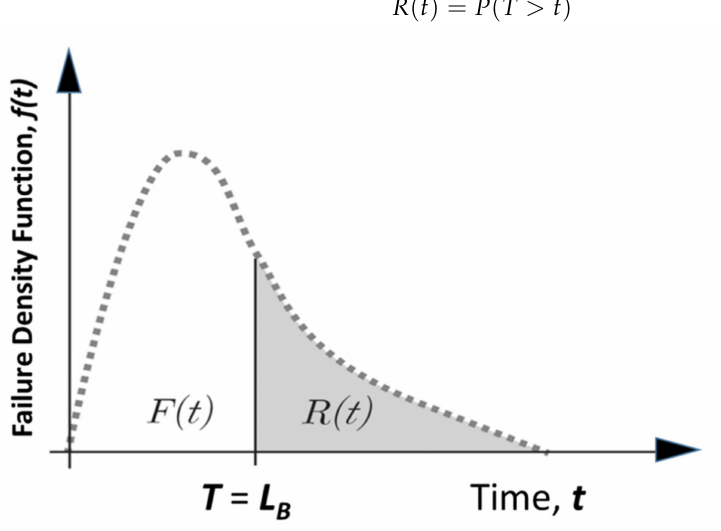
Figure 2. Reliability function R ( t ) and cumulative distribution function F ( t